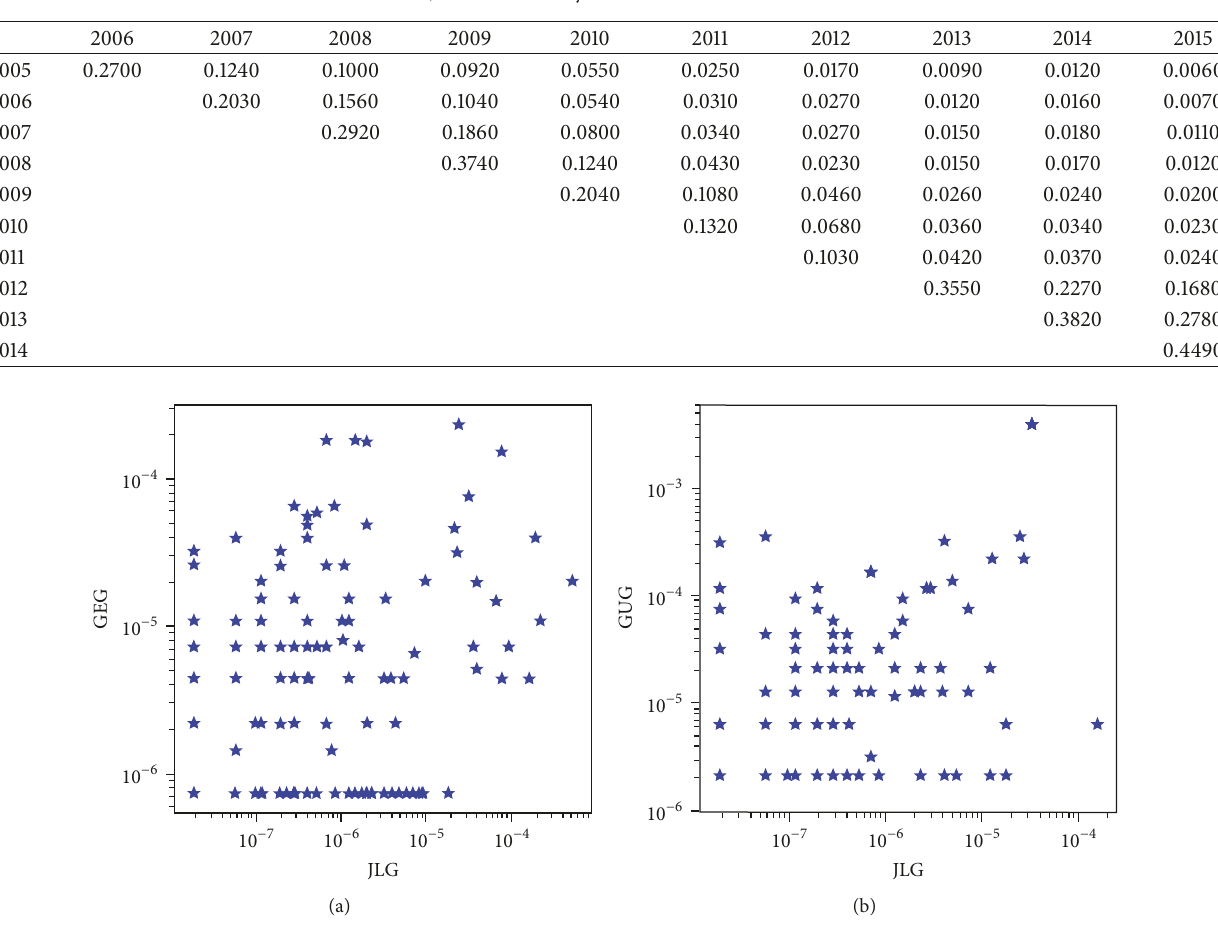
Figure 2: Betweenness centrality of the multiplex network.